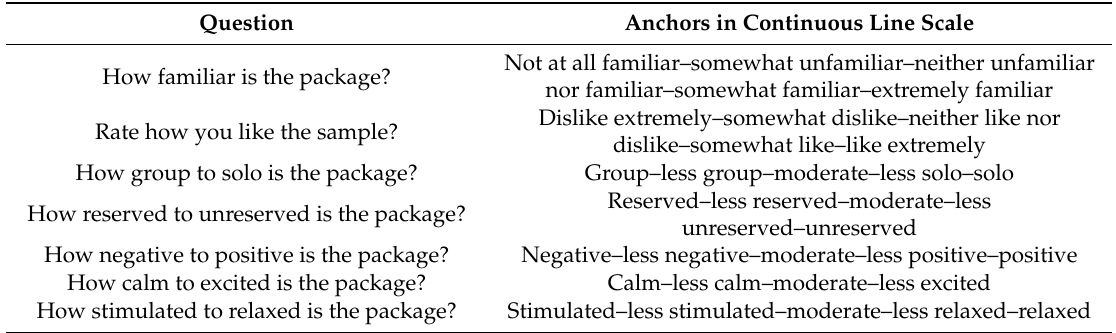
Table 1. Questions for self-reported responses and the answer options provided to panelists. The categories were equally spaced in the answer options, and the panelists could mark their response anywhere within the